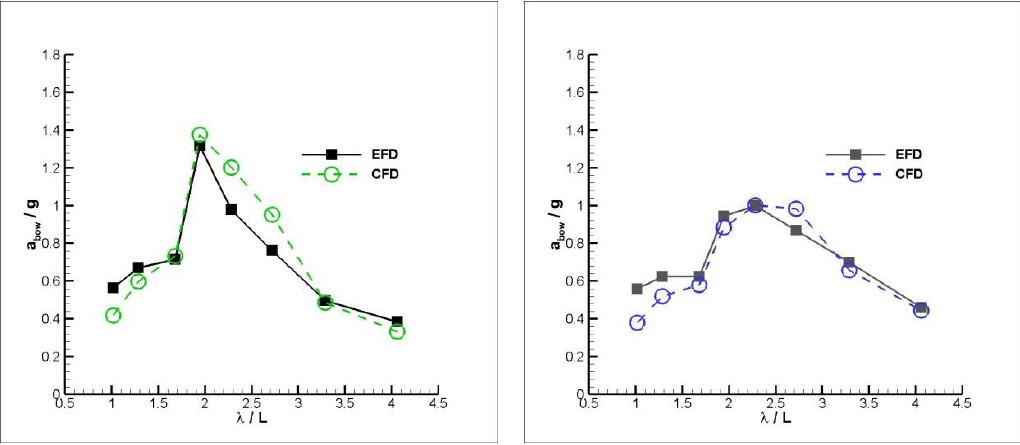
Figure 16. Bow accelerations for mono ( left ) and warped ( right ) hulls at Fn B = 2.26.